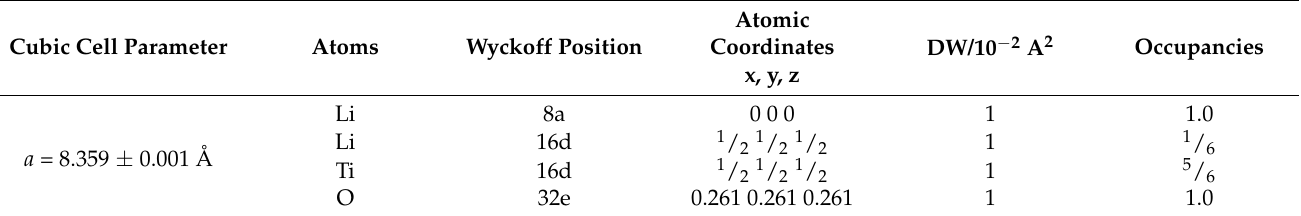
Table 2. Crystal structure parameters of the LTO spinel lattice (space group Fd-3m, number 227 origin choice 1, and DW = Debye Waller factor).